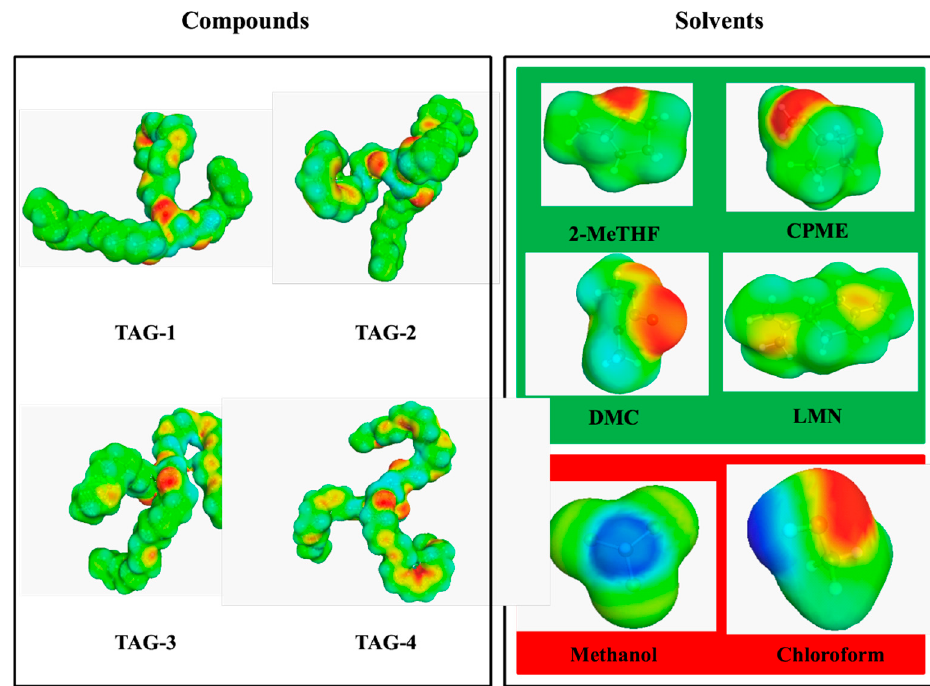
Figure 1. Model of α -surfaces by COSMO-RS of compounds and solvents used in the theoretical study. Compounds (TGAs): TAG-1 (R1 (C16:0); R2 (C22:6n3); R3 (C16:0)); TAG-2 (R1 (C18:1n9); R2 (C20:5n3); R3 (C16:0)); TAG-3 (R1 (C18:1n9); R2 (C22:6n3); R3 (C18:1n9)); TAG-4 (R1 (C22:6n3); R2 (C22:6n3); R3 (C22:6n3)). Green solvents (green color): 2-methyltetrahydrofuran (2-MeTHF), cyclopentyl methyl ether (CPME), dimethyl carbonate (DMC) and limonene (LMN). Reference solvent (red color): Folch reagent (FR), chloroform/methanol (2:1, v/v).